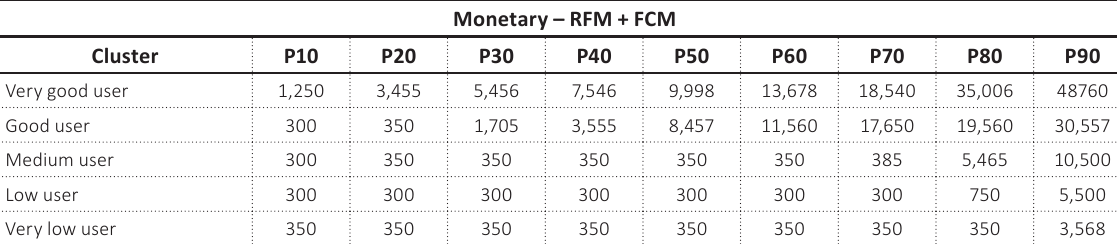
Table 6. Monetary value